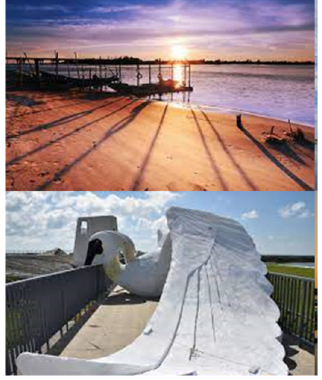
Figure 3. Attractions of the Cigu area.